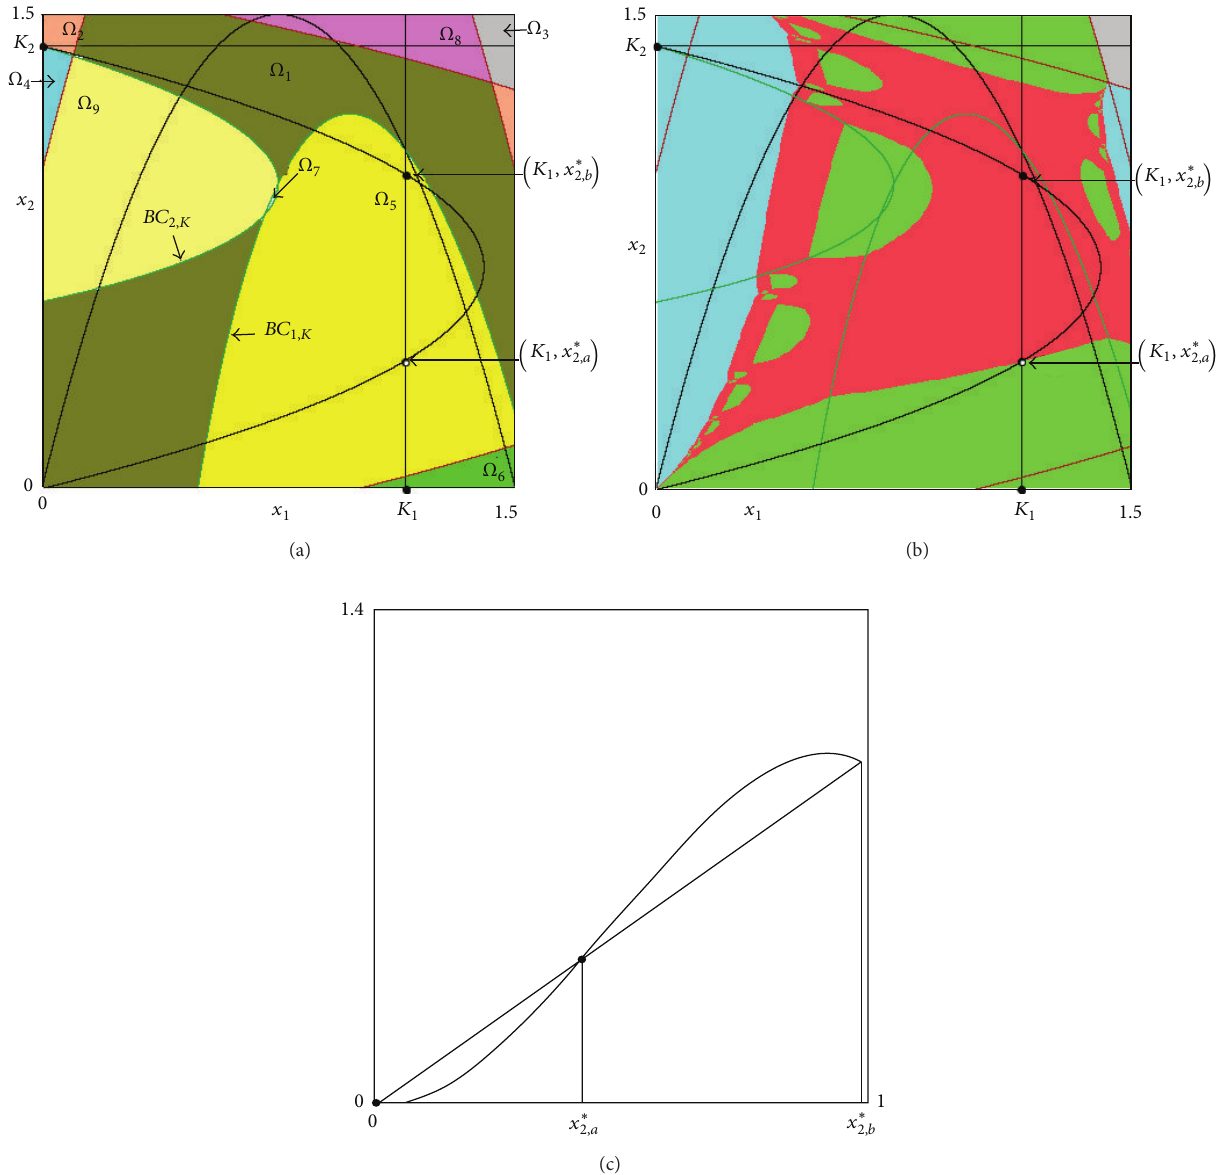
Figure 1: Parameters: 𝑁 1 = 1.5 , 𝑁 2 = 1.4 , 𝜏 1 = 𝜏 2 = 4 , 𝛾 1 = 𝛾 2 = 1 , 𝐾 1 = 1.15 , and 𝐾 2 = 1.4 . Panel (a), phase space divided in regions Ω 𝑖 , 𝑖 = 1,...,9 . Panel (b), the green (resp., azure) region is the basin of attraction of the superstable equilibrium of segregation (𝐾 ) ), and the red region is the basin of attraction of the equilibrium of nonsegregation (𝐾 (0,𝐾 2 are the dark-green curves and 𝐵𝐶 1,0 and 𝐵𝐶 2,0 the dark-red curves, while 𝜙 1 and 𝜙 2 are the black curves. Panel (c), graph of the restriction of the map 𝑇 on 𝑥 1 = 𝐾 1 for 𝑥 2 ∈ [0,𝑥 2,𝑚 ]